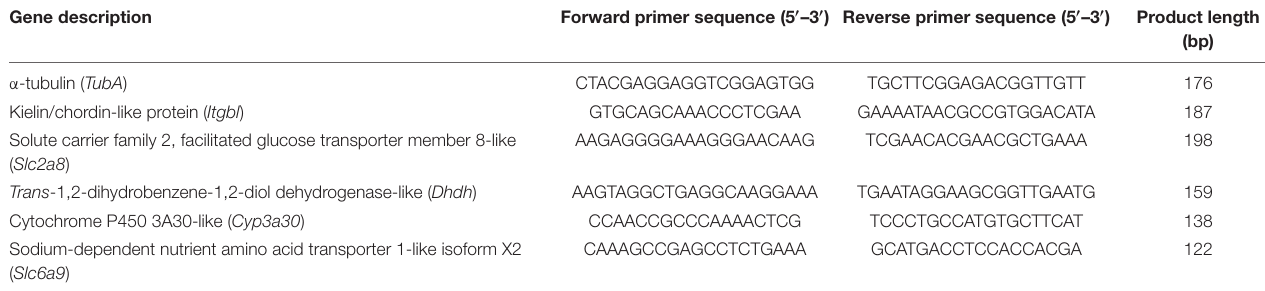
TABLE 1 | Primers used for real-time quantitative PCR. Gene description